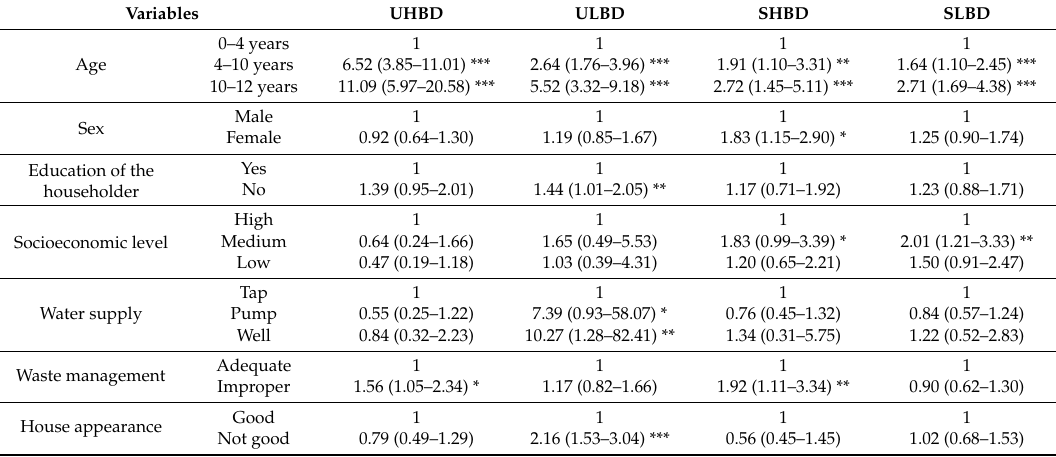
Table 3. Factors associated with flavivirus